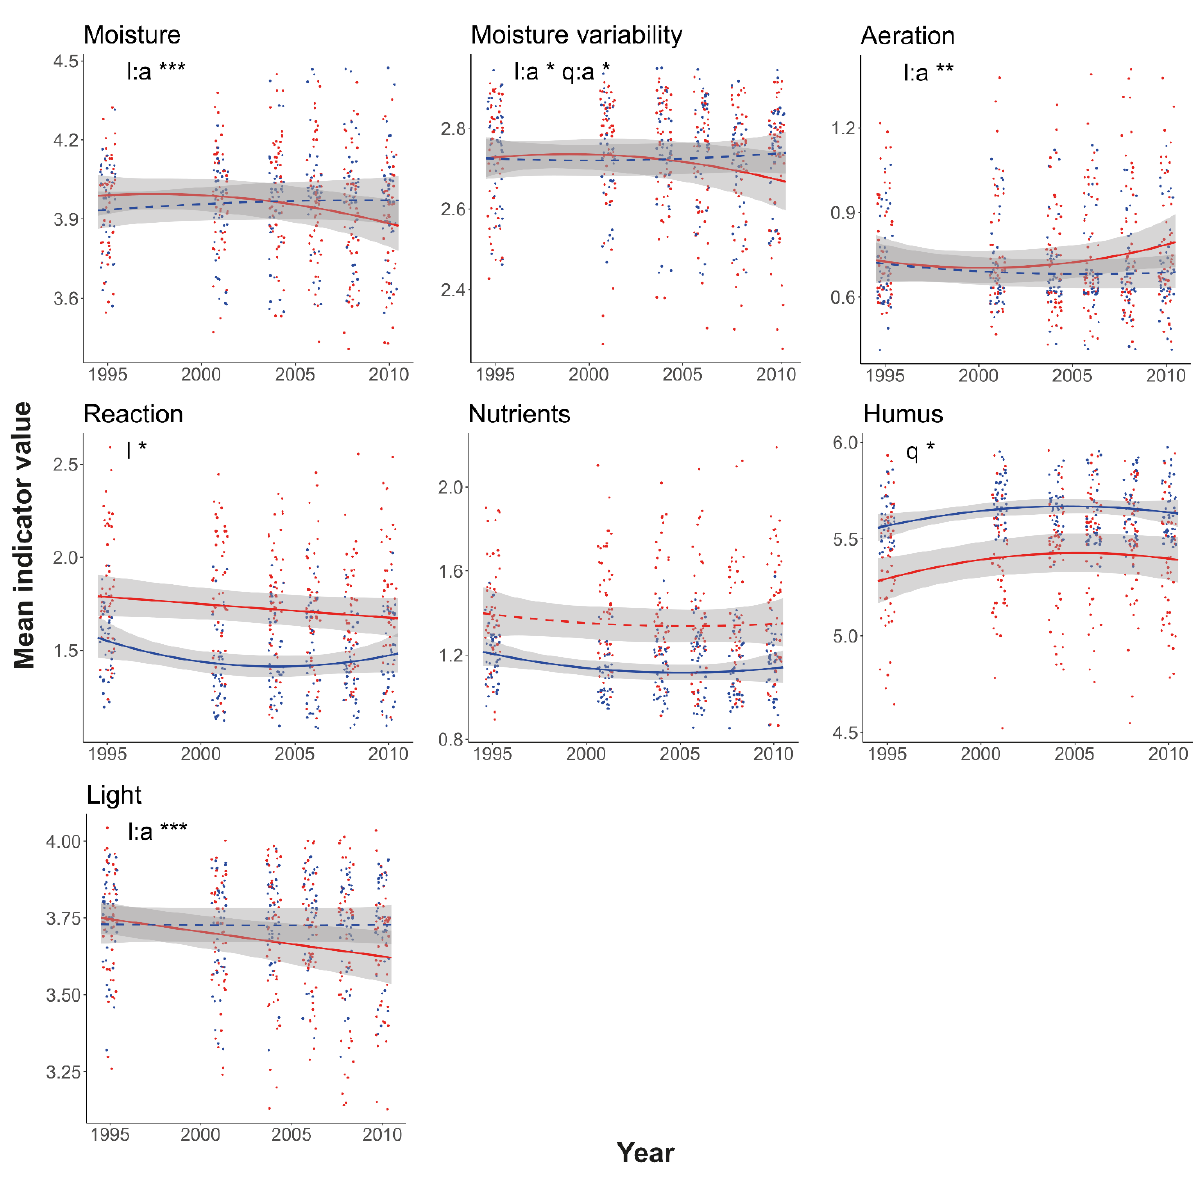
Figure 3. Trends of mean indicator values for GC-areas (grazing cessation, red) and GCR-areas (grazing cessation plus rewetting, blue). Regression lines and confidence intervals from individual models are displayed. Solid lines show significant trend components. Dashed lines show the model fit of both trend components, if neither of them is significant. Labels denote significant trend differences or significant overall trends derived from the common model. Dots indicate observed values on single plots. Outliers are not shown. l = linear time component; q = quadratic time component; a = area type; a colon indicates an interaction. Significance levels: *: p ≤ 0.05; **: p ≤ 0.01; ***: p ≤ 0.001.